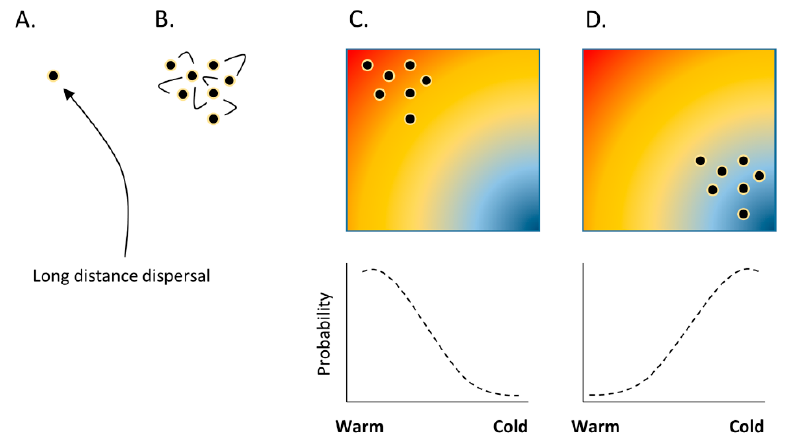
Figure 2. Graphic to demonstrate a null hypothesis of climatic control. ( A. ) Species larger-scale distributions can be shaped by long distance dispersal; ( B. ) Irrespective of environmental control, short distance dispersal can create aggregated distributions on ecological timescales; ( C. ) This aggregated distribution is compared to an autocorrelated climate surface to generate a ‘good’ statistical model; ( D. ) Randomly positioning the aggregated distribution in an alternative part of geographic space would generate a different but equally good model, rendering diagnostics for model fit spurious as hypothesis tests for climatic control of species distributions.